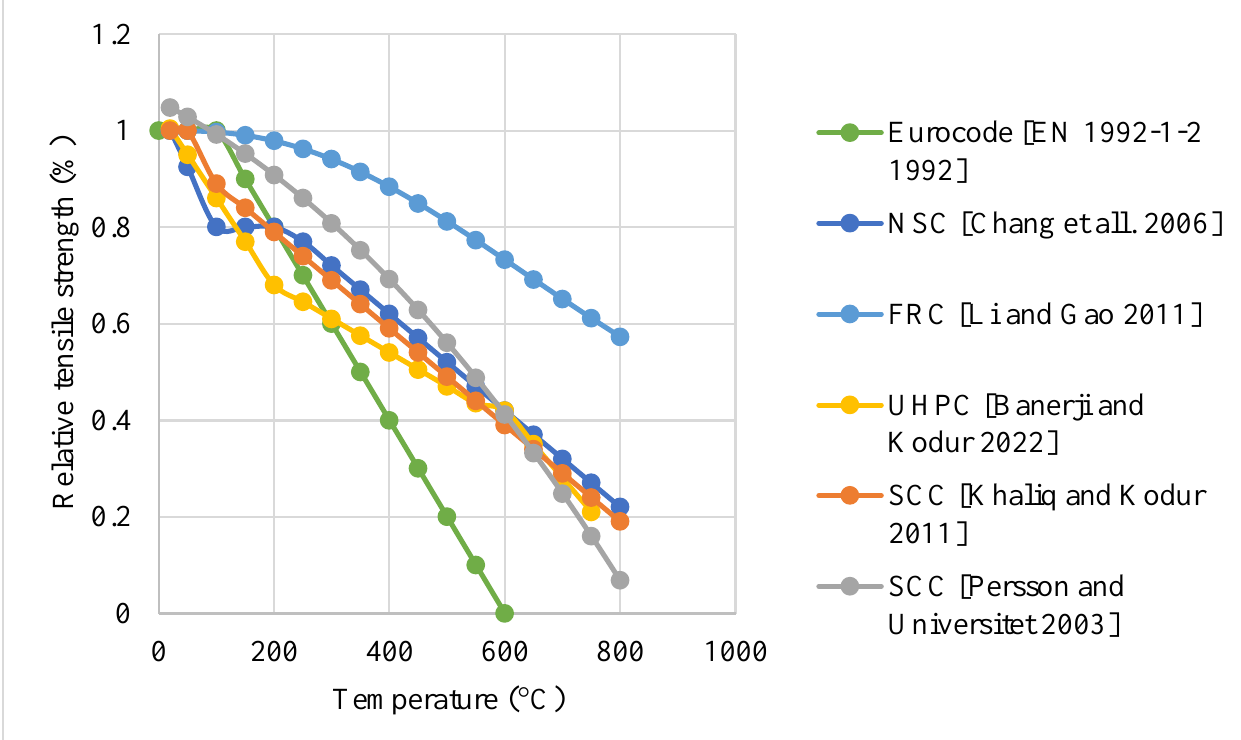
Figure 48. Relative tensile strength models for different types of concrete [5,48,84,97,108,135].